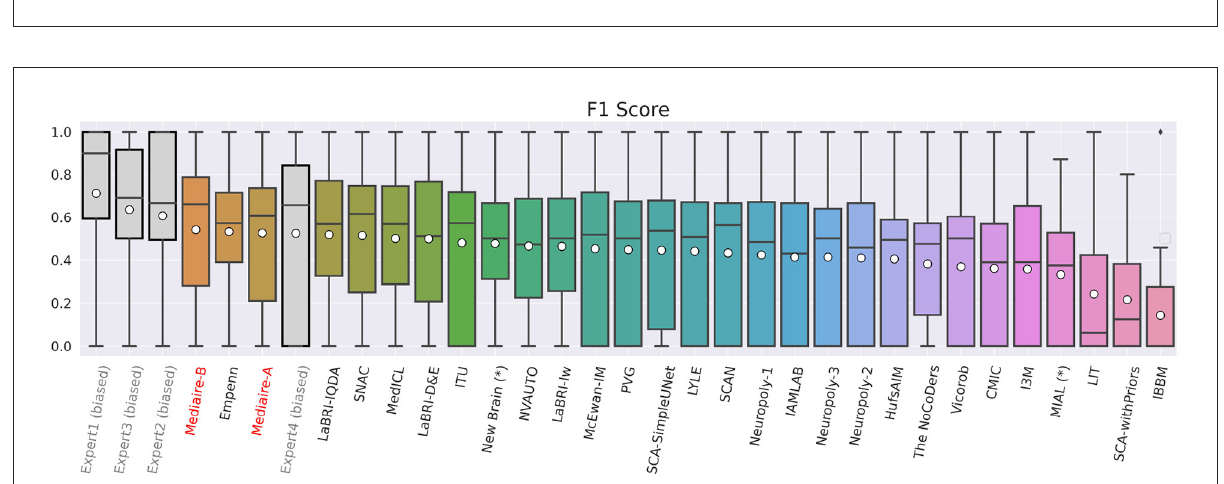
FIGURE5 F1 scores of experts (gray), our pipelines mediaire-A and mediaire-B (red), and the models submitted by the other MSSEG-2 participants (black), calculated on the 32 datasets in TEST-MSSEG2-NL, all of which exhibited new MS lesions. Horizontal bars indicate the median and white circles the mean values. All experts and models are ordered by their mean F1 score, which also determined the ranking of the main challenge leaderboard. The three best performing methods are our pipeline mediaire-B, Empenn, and pipeline mediaire-A. The scores of the expert segmentations are shown for reference, however, these scores are biased as discussed in Section